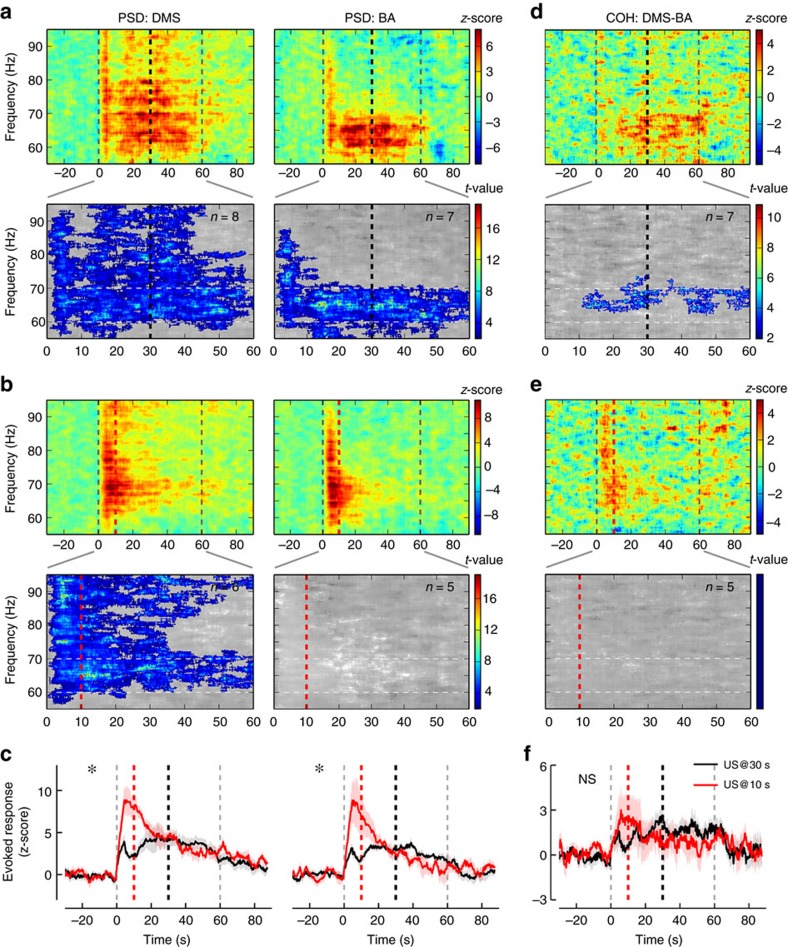
Time-related oscillatory changes in the 60–70 Hz frequency band recorded from DMS and BA during CS alone presentations.(a) Relative change in LFP power for the DMS (upper left) and the BA (upper right) before, during and after 60 s CS presentation (onset and offset marked by dashed grey lines) when the US is expected 30 s after the CS onset (thick black dashed line). The relative change with respect to pre-stimulus baseline per frequency shows increased activity in a the 60–95Hz range in the DMS and in the 60–70 Hz range in the BA. Non-parametric cluster analysis (lower panels) reveals significant (P<0.05) power spectrum increases for the DMS and the BA during the CS presentation. The grey colour code depicts non-significant changes as t-values. Expected time of US arrival at 30 s is shown by a thick black dashed line. (b) Relative change in LFP power for the DMS (upper left) and the BA (upper right) before, during and after CS presentation after the US arrival was shifted to 10 s (thick red dashed line). Same depiction as in a. Significant increases in the LFP power are observed in the DMS (lower left) but not in the BA (lower right). (c) Comparison of the mean±s.e.m. change in LFP power in the 60–70 Hz frequency band between 30 s (black) and 10 s (red) expected time of US arrival conditions (DMS: left panel; BA: right panel). Stars mark significant time X condition interaction (two-way ANOVA with Geisser and Greenhouse correction; both P<0.01). (d) Relative change in LFP coherence between DMS and BA before, during and after CS presentation in the 30 s condition (upper panel). Cluster analysis (lower panel). (e) Relative change in LFP coherence between DMS and BA after the US arrival was shifted to 10 s. Same depiction as in d. No significant coherence increases occur during stimulus presentation (see lower panel). (f) Comparison of the relative coherence dynamics in the 60–70 Hz frequency band between 30 s (black) and 10 s (red) US arrival conditions.